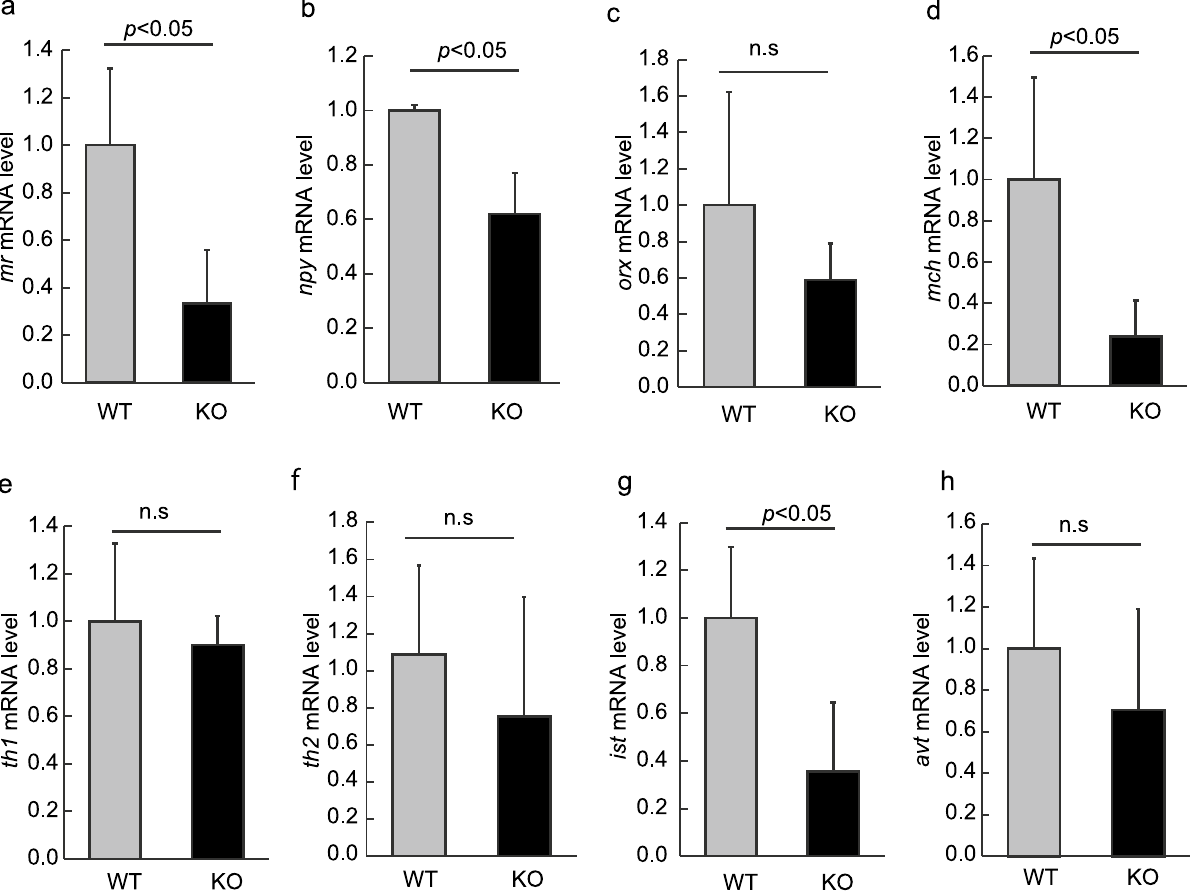
Figure 6. Changes in gene expression in Neu1-KO zebrafish. mRNA levels of mr ( a ), npy ( b ), orx ( c ), mch ( d ), th1 ( e ), th2 ( f ), ist ( g ), and avt ( h ) in WT and Neu1-KO zebrafish. Each level of gene expression in Neu1-KO zebrafish is relative to the value in WT fish. n = 5 for each group. Results are shown as means ± standard deviation. All values were compared using Mann–Whitney U test. n.s., not